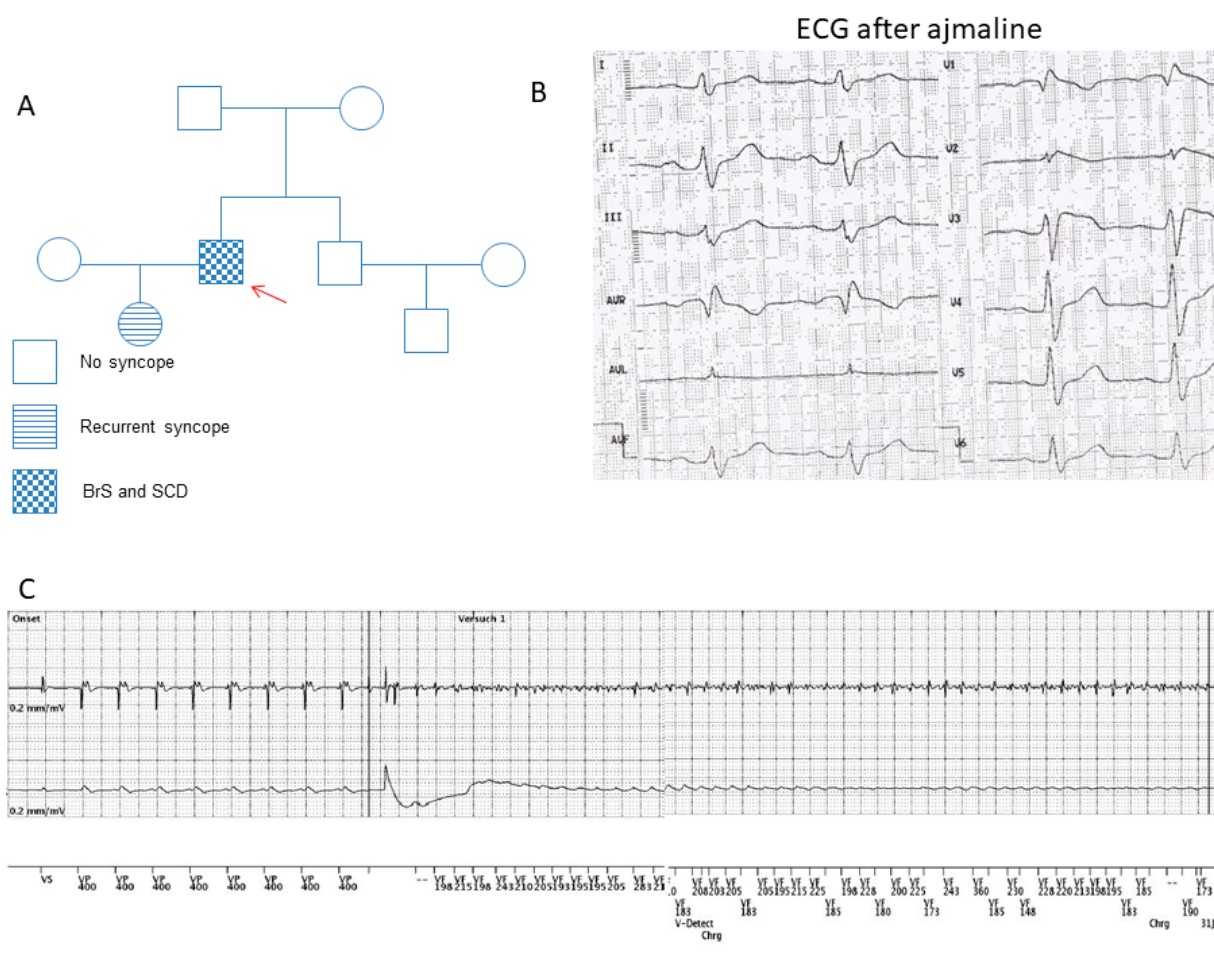
Figure 1. Clinical characteristics of the BrS patient. ( A ) The pedigree of the BrS patient’s family. The patient recruited for this study is marked by the arrow. He has had sudden cardiac death. ( B ) The electrocardiogram (ECG) from the BrS patient shows a classic BrS–ECG pattern after infusion of ajmaline. ( C ) Electrocardiogram of the ICD showing ventricular fibrillation terminated with an appropriate ICD shock after stopping the bisoprolol treatment.